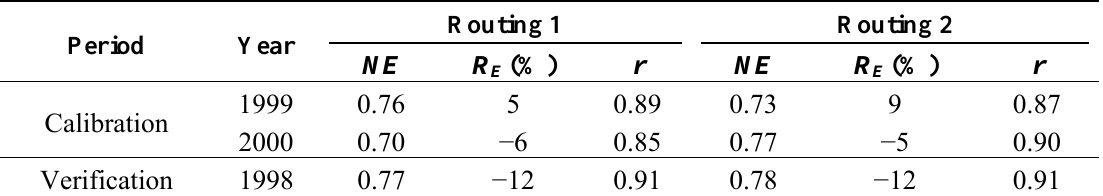
Table 3. Simulation results by using TOPMODEL and the original and new routing algorithms. Period